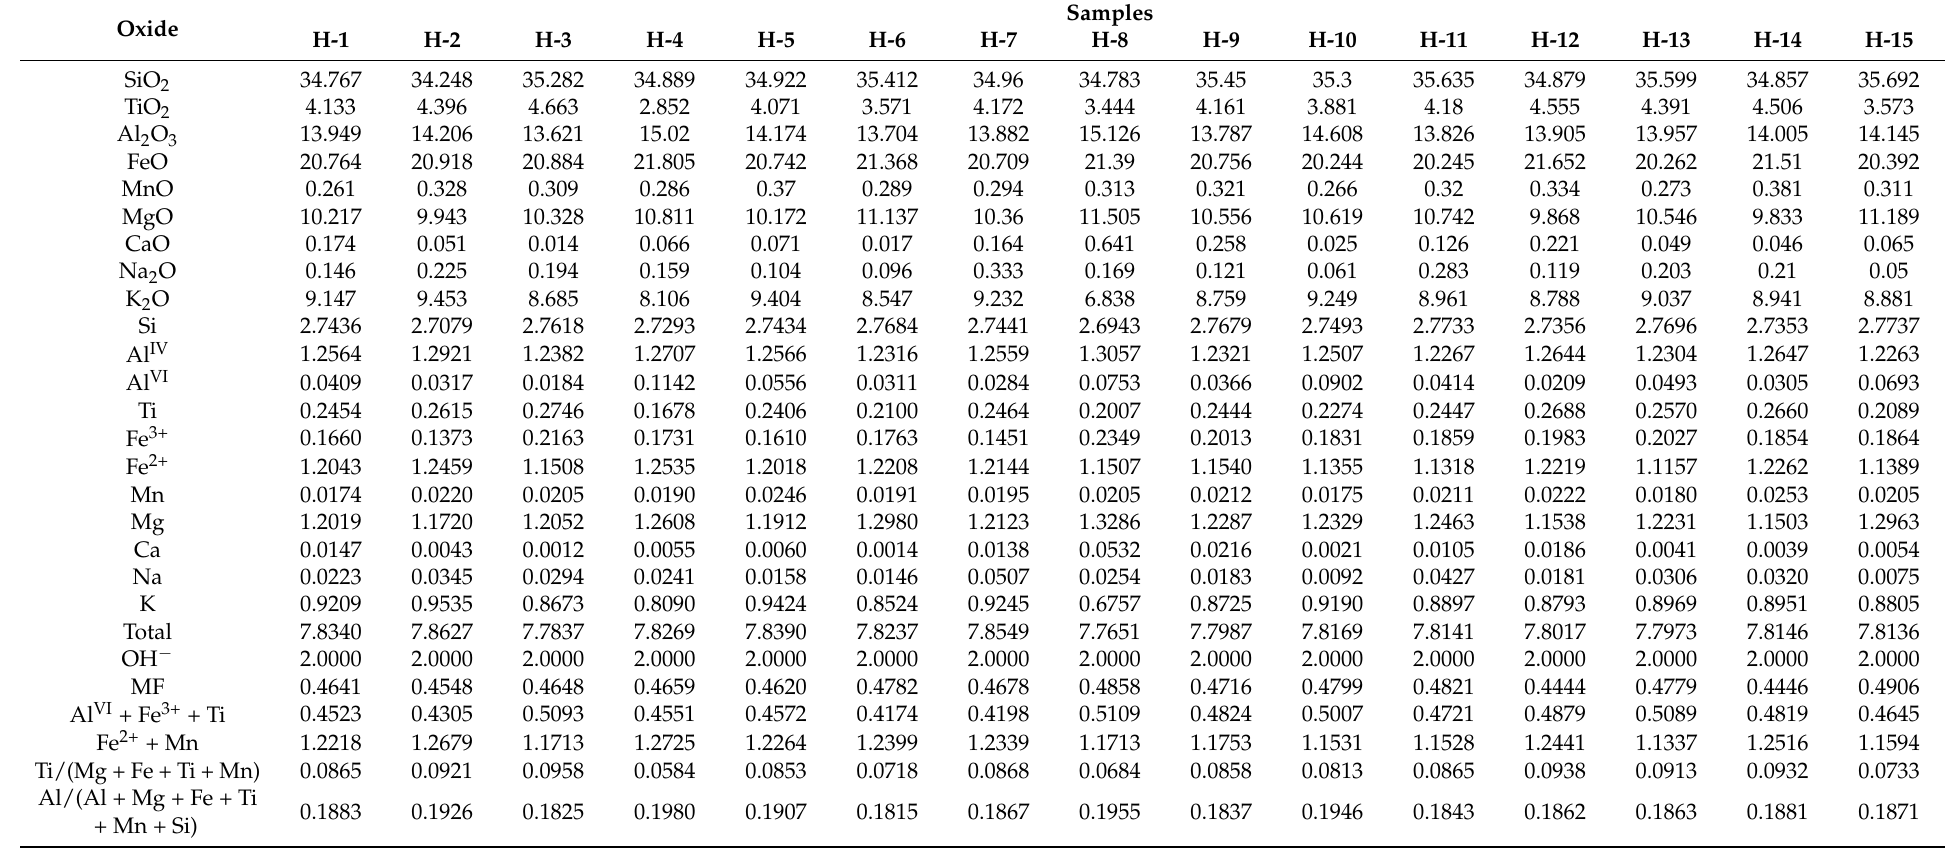
Table 4. Composition of biotite in Zhouguan